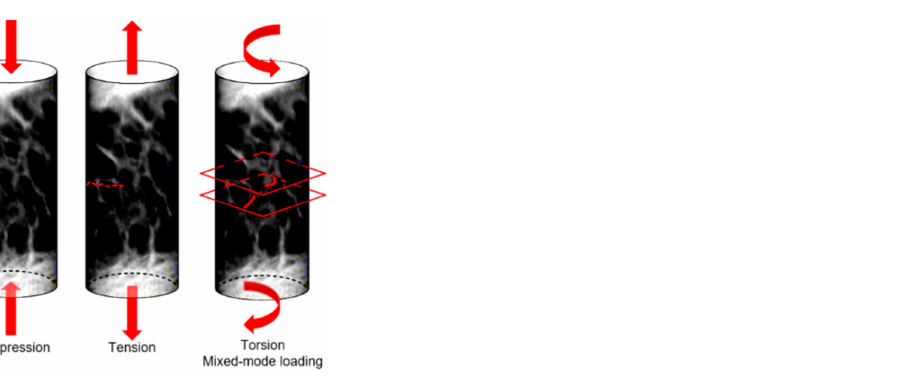
Figure 6. Orientation of micro-cracks in a bone sample subjected to different loading conditions.